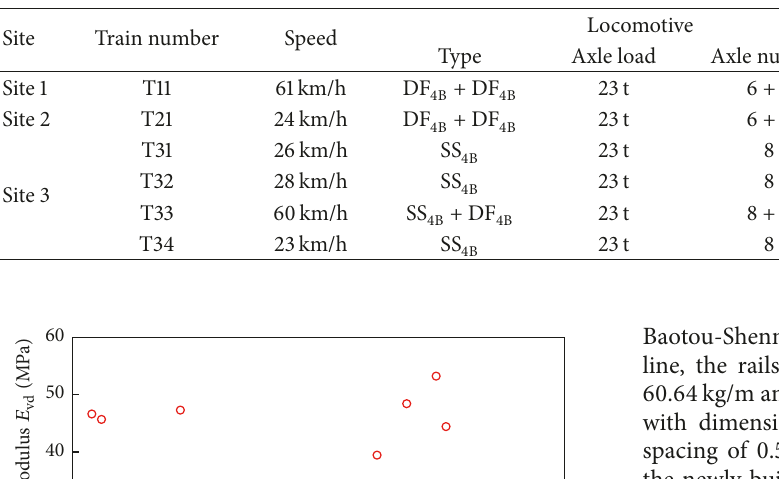
Table 1: Formations of locomotive and wagon.